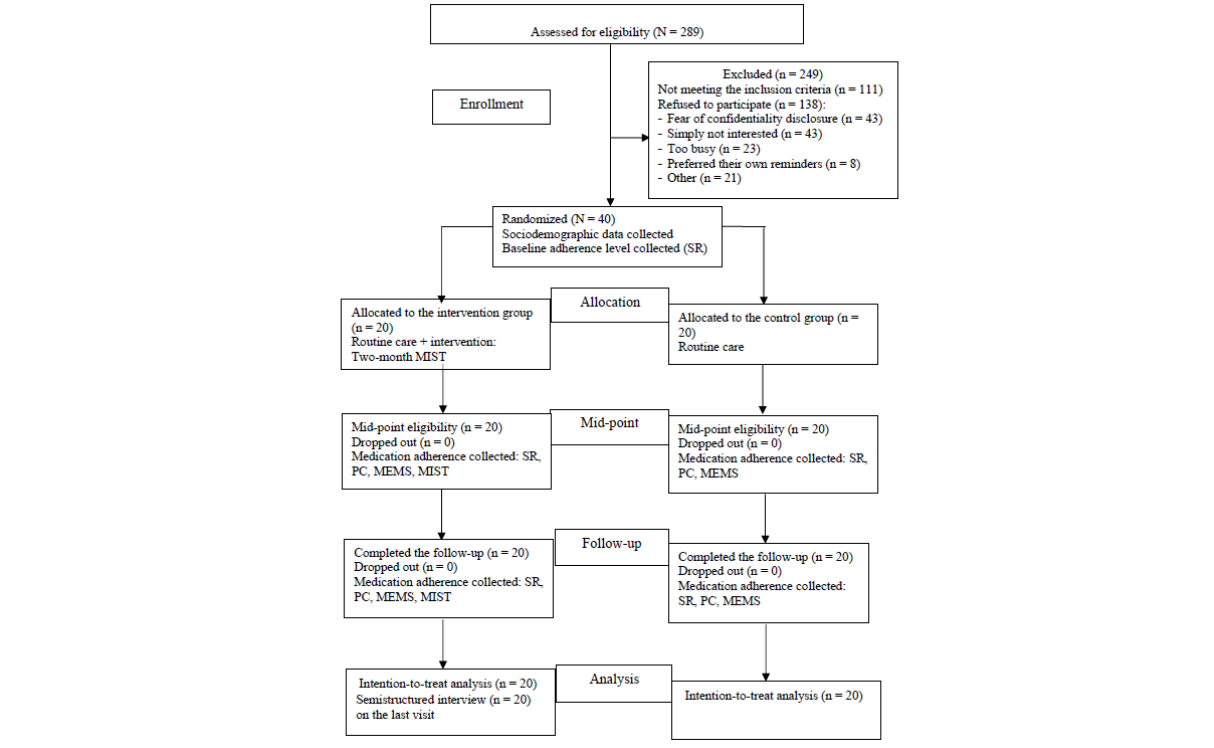
Figure 1. The consolidated standards of reporting trial chart. MEMS: Medical Event Monitoring System; MIST: Mobile Interactive Supervised